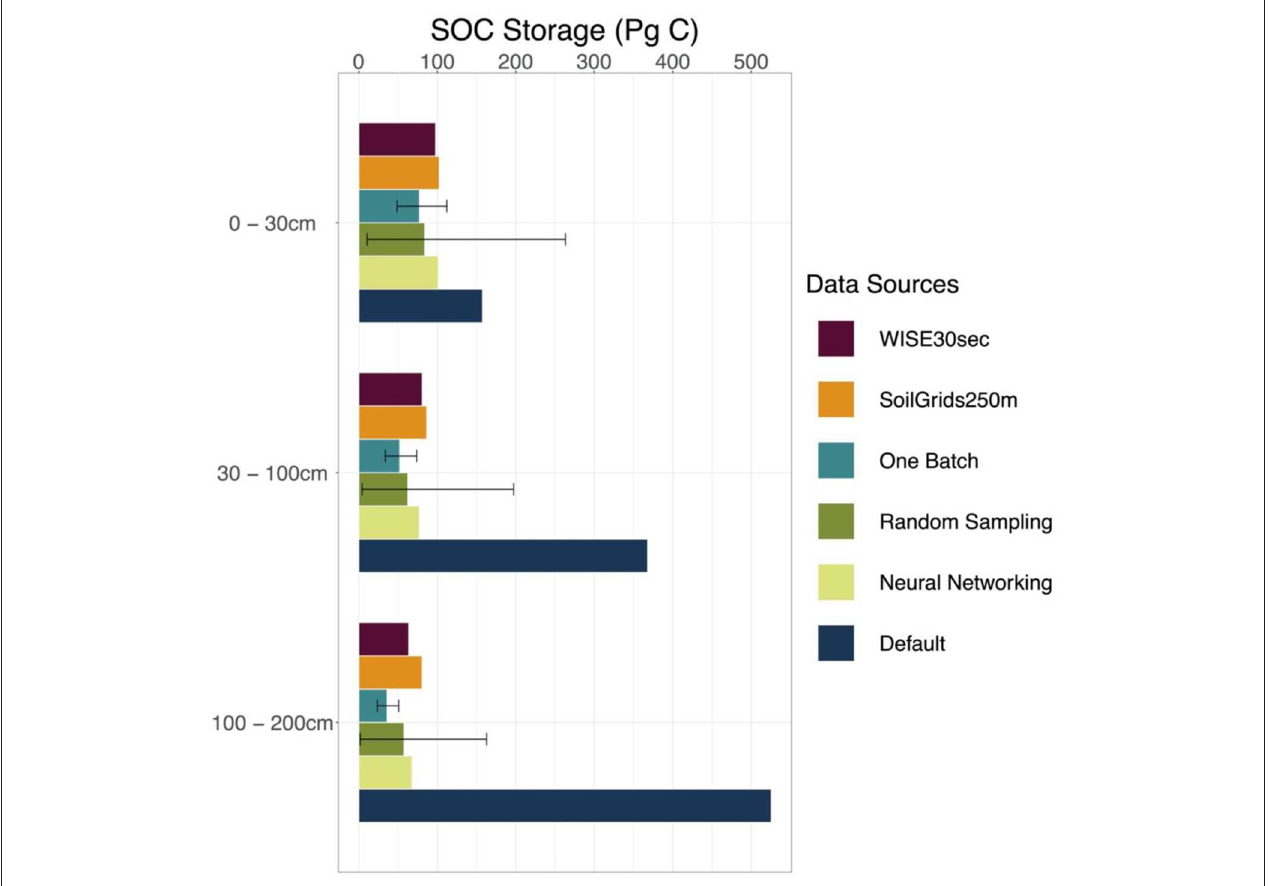
FIGURE 4 | SOC storage estimated by different methods and data sources. Estimations on the SOC storage of the conterminous United States by different methods discussed in this study (one-batch, random-sampling, and neural networking methods) and data sources (original model output with default parameterization, WISE30sec, and SoilGrids250m) were presented by three depth intervals, which are 0–30, 30–100, 100–200cm, respectively. The error bars for the random-sampling method and the one-batch method present the intervals between the 5 and 95% quantiles in the 1,000